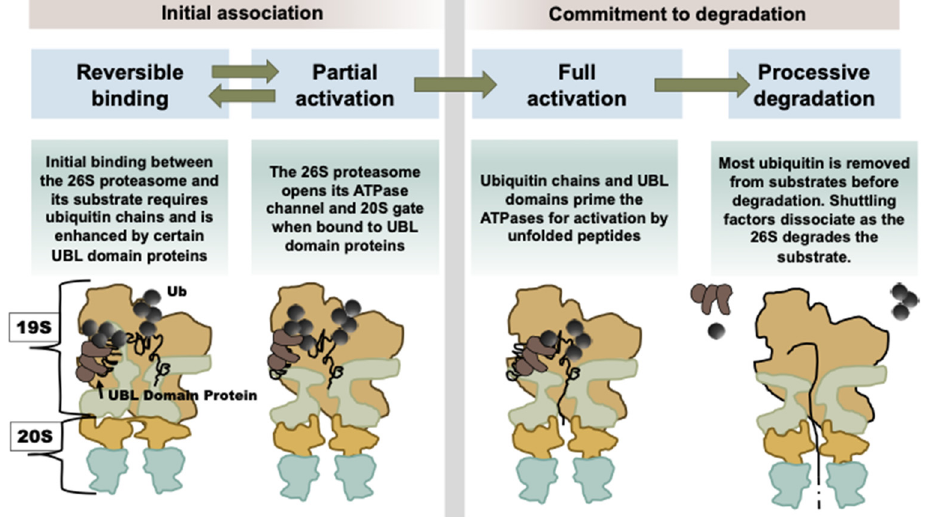
Figure 3. Our present understanding of how UBL-UBA shuttling factors stimulate proteasomal degradation of client proteins. This mechanism summarizes multiple steps leading to processive degradation. Shuttling factors (Rad23A, Rad23B, Ddi2, Ubqln1, Ubqln2, and Ubqln4) facilitate the delivery of ubiquitinated proteins to proteasomes and, with their UBL domains, trigger this multistep activation mechanism, which involves stimulating the ATPases (the light green objects in the 19S particle) and opening the gates of the 20S α -subunits (the orange objects in the 20S particle) (for further discussion, see [31]).